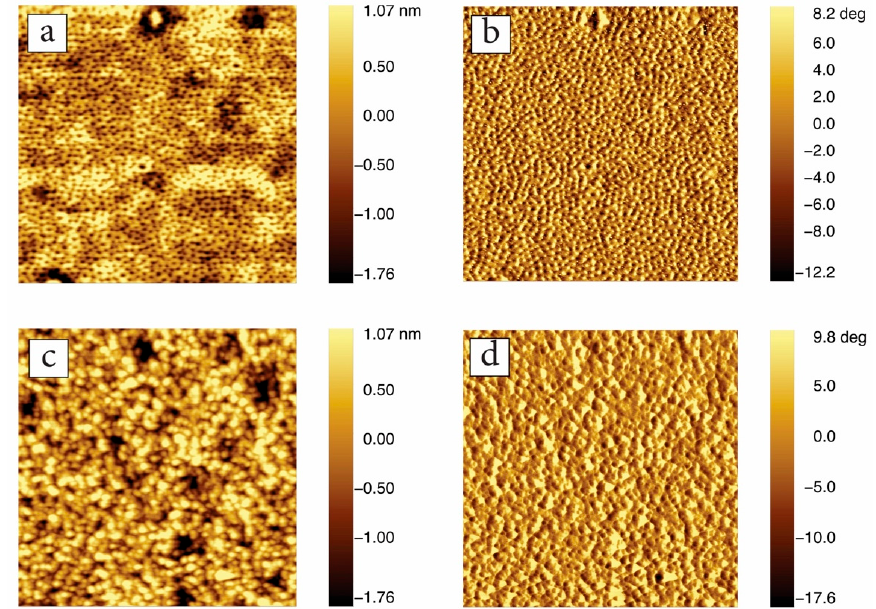
Figure 6. SFM topography ( a , c ) and phase ( b , d ) images (1 µ m × 1 µ m) before ( a , b ) and after ( c , d ) in-situ measurements with ultra-pure water upon UV cleavage for 4 h.